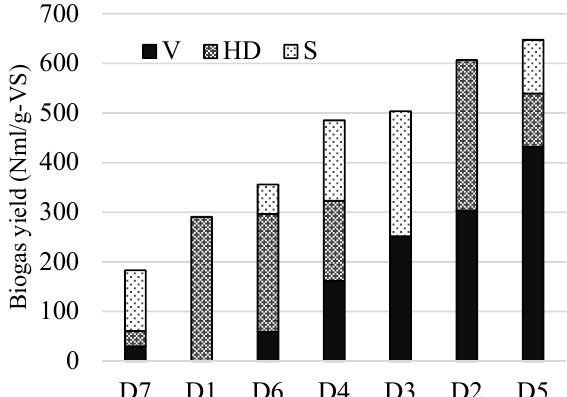
Fig. 2: Biogas yield and substrate compositions in reactors